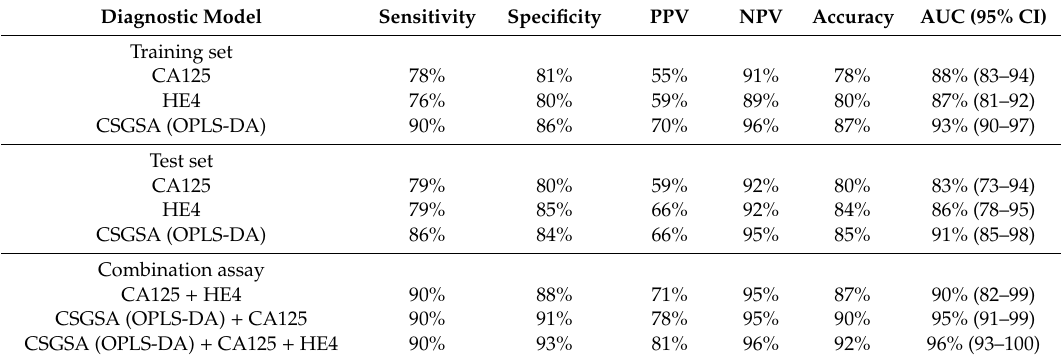
Table 1. Diagnostic performance for stage I epithelial ovarian cancer versus non-EOC controls. Diagnostic Model